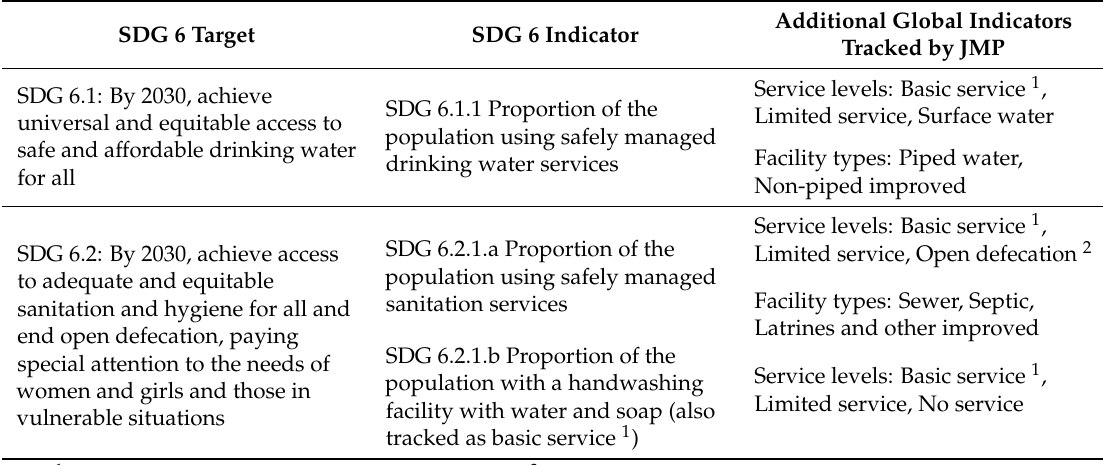
Table 1. SDG targets and global indicators for household